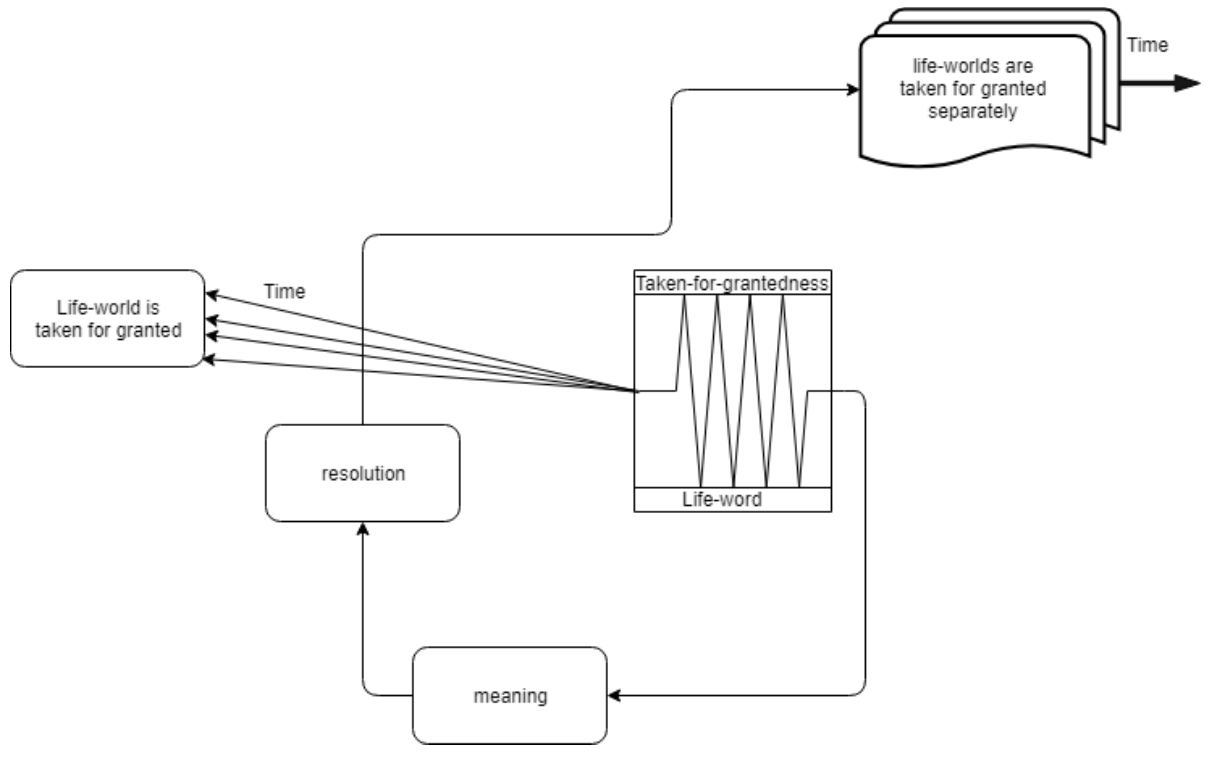
Figure 2: Model of learning from the experience of indebtedness. Modification of Jarvis' model (own